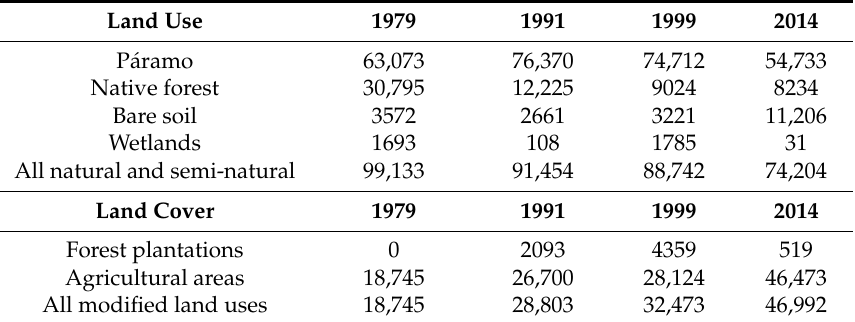
Table 2. Chambo basin: land use and land cover in 1979, 1991, 1999 and 2014 (ha). Land